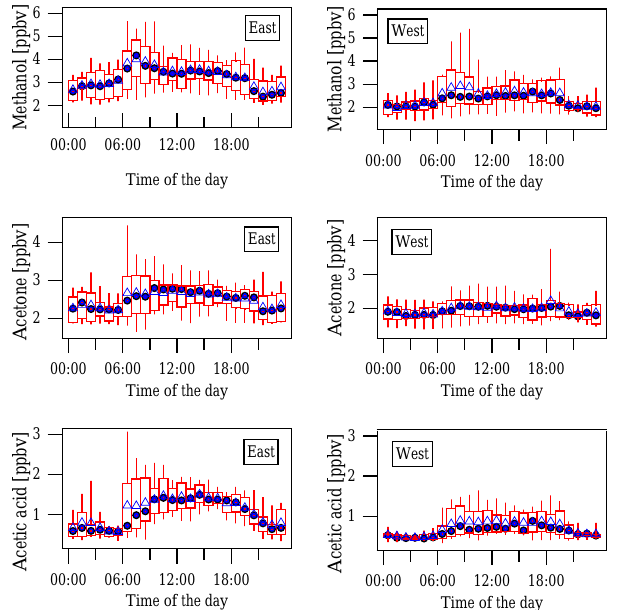
Figure 4. Box-and-whisker plot of acetone, methanol and acetic acid when the site was within the PBL. The triangles refer to mean and the circles to median values. The box contains 50% of the data. 25% of the data lie below the lower end of the box, 75% below the upper end. The whiskers present the 5–95% range of the